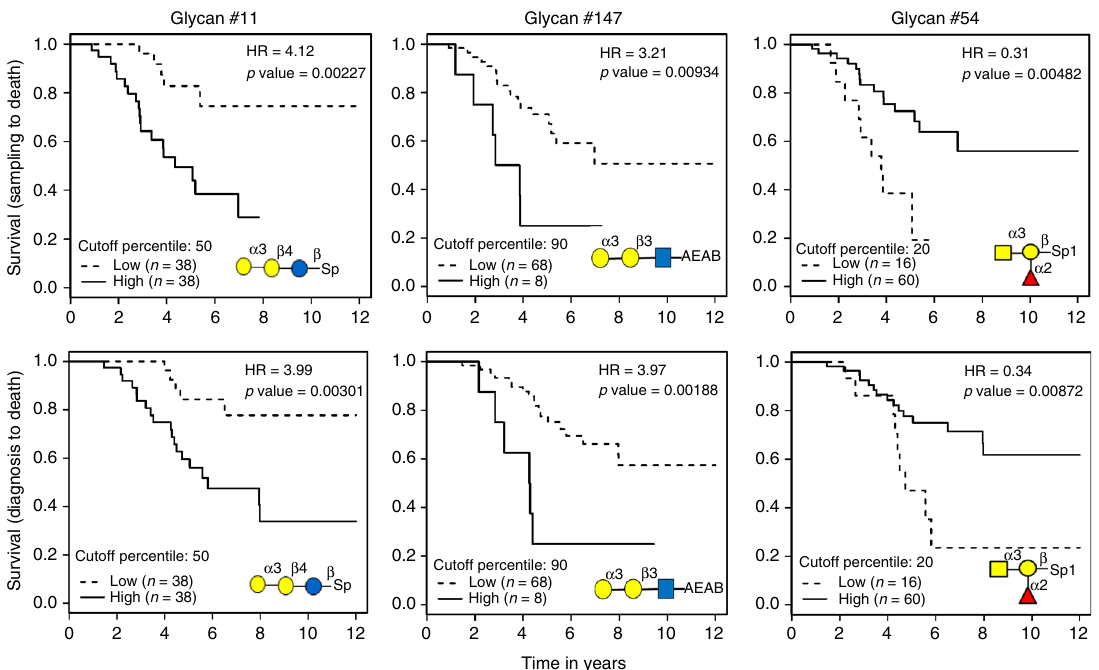
Fig. 6 Kaplan – Meier survival analyses of ovarian cancer patients. Analysis was done using date of sample collection to death (top row) and date of diagnosis to death (bottom row). The subjects were assigned to the low- (dashed lines) or high- (solid lines) level groups based on the anti-glycan IgG levels for each glycan. The data for three glycans are shown here. The hazards ratio (HR) was determined by Cox regression analysis and the p values